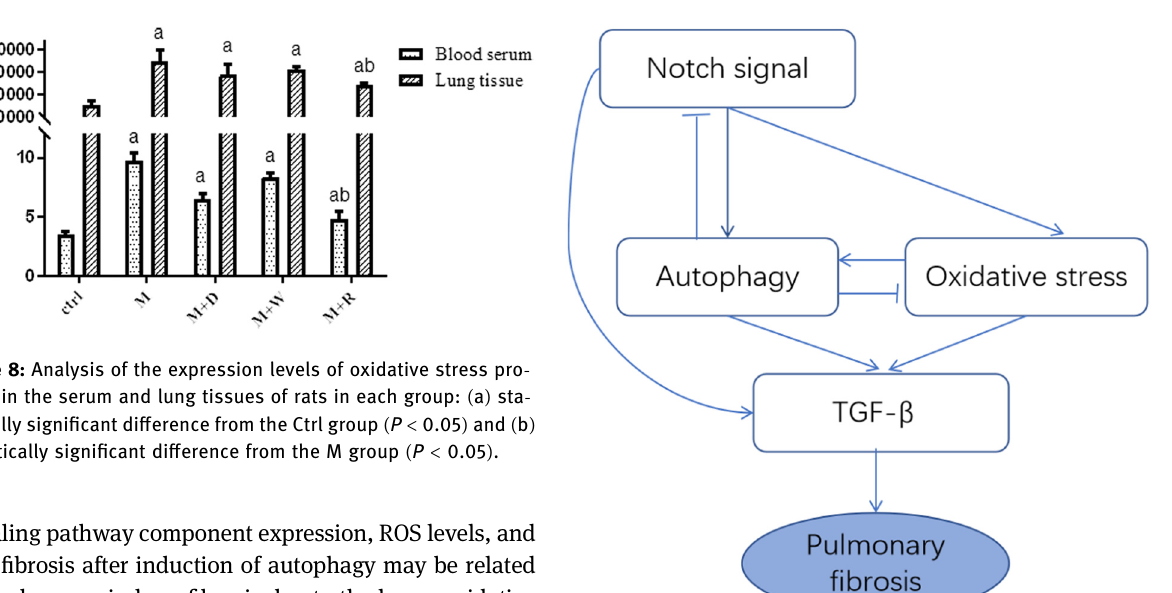
Figure 7: Electron microscopy of the mitochondrial structure of the lung tissue in each group. The observation fl ow chart is shown in the upper right panel.